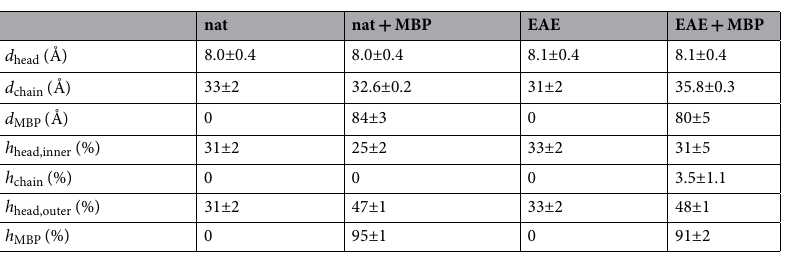
Table 1. Thicknesses d i and hydration (buffer penetration) h i of head, chain and MBP sections of native